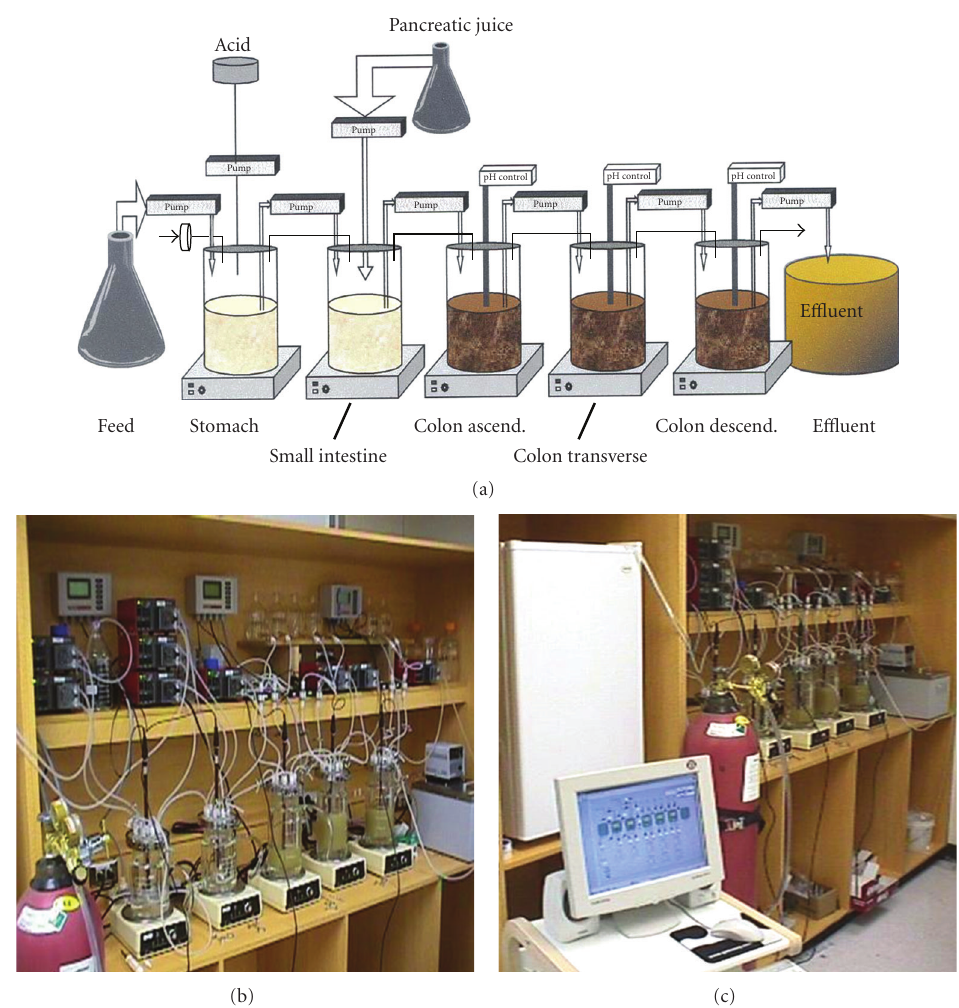
Figure 1: Computer controlled dynamic in vitro human GI model. (a) schematic; (b) 5-bioreactors set-up; and (c) online computer control.